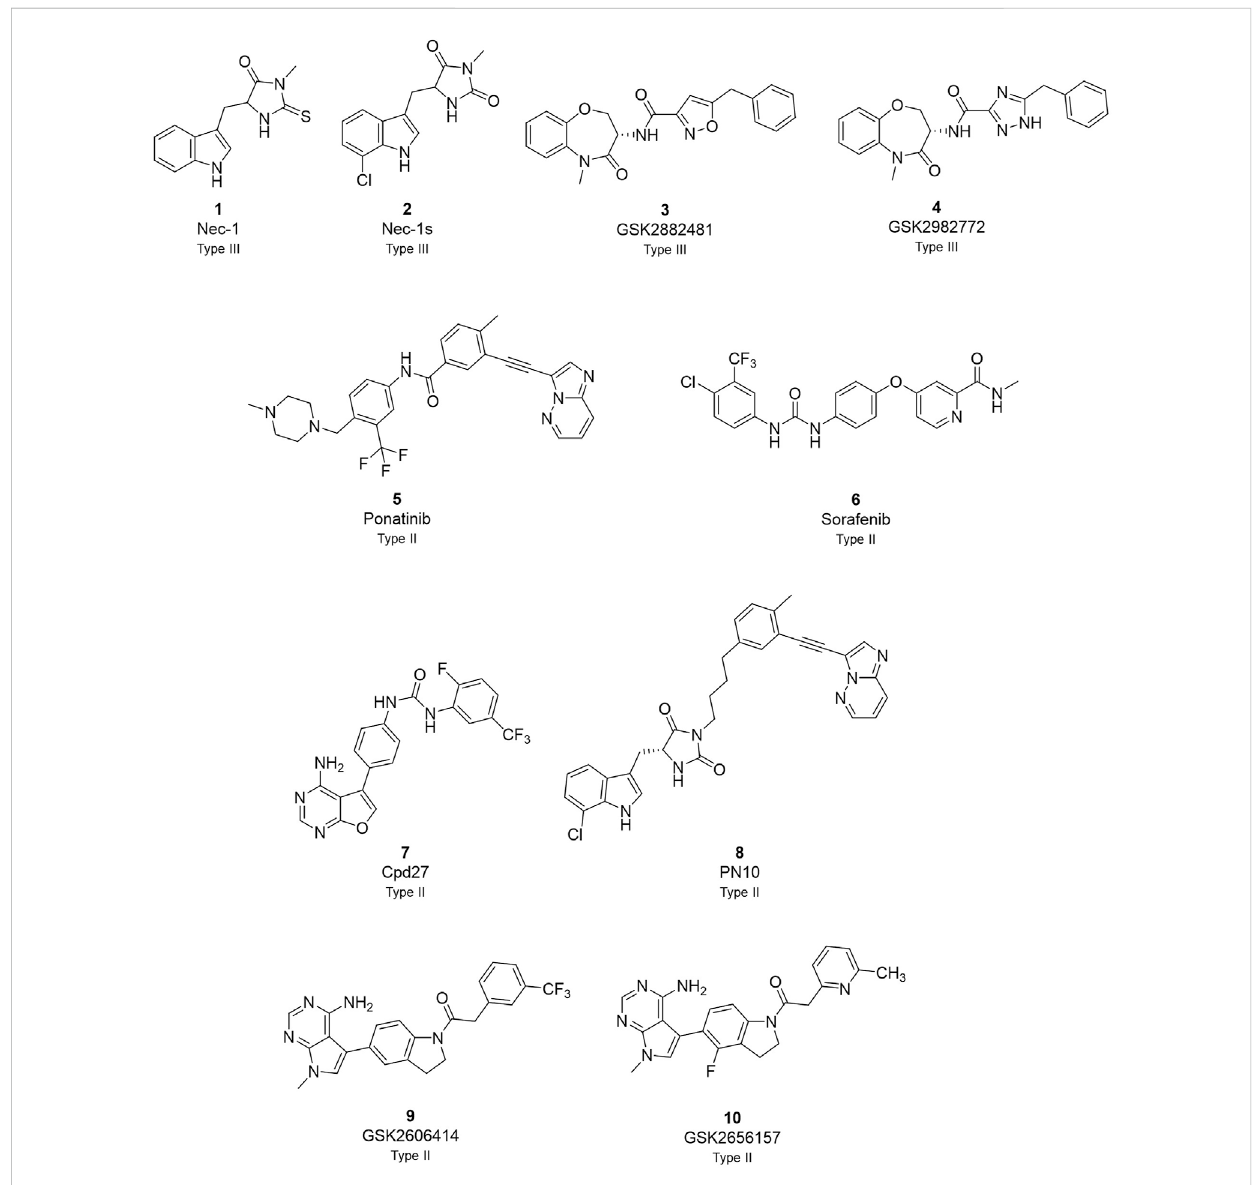
FIGURE 1 Overview of currently known RIPK1